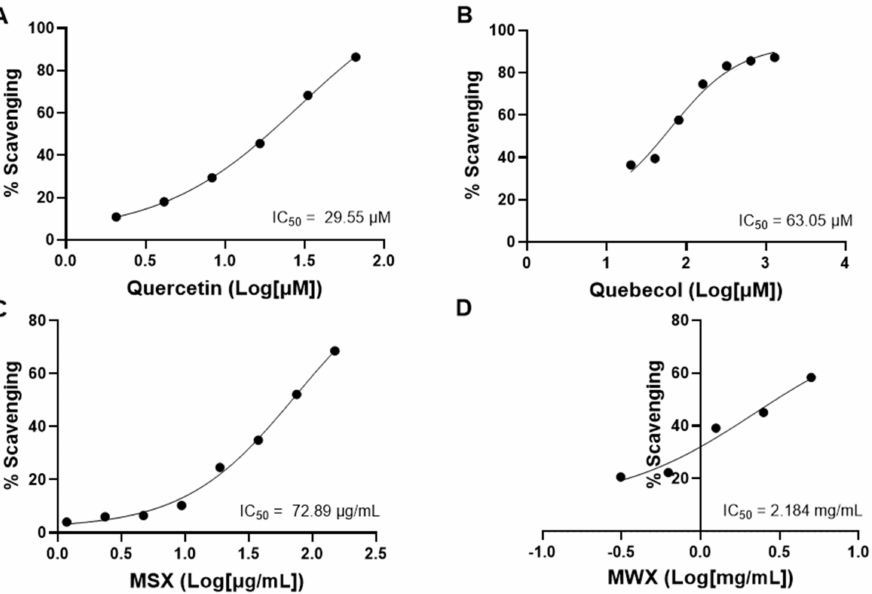
Figure 5. Antioxidant effects of a phenolic free radical scavenger quercetin ( A ), a unique phenolic named quebecol isolated from maple syrup ( B ), MSX ( C ), and MWX ( D ) evaluated by the DPPH